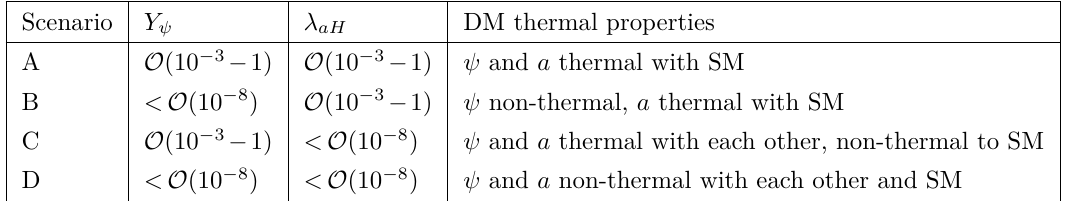
Table 3. Table of distinct phenomenological DM scenarios possible in this